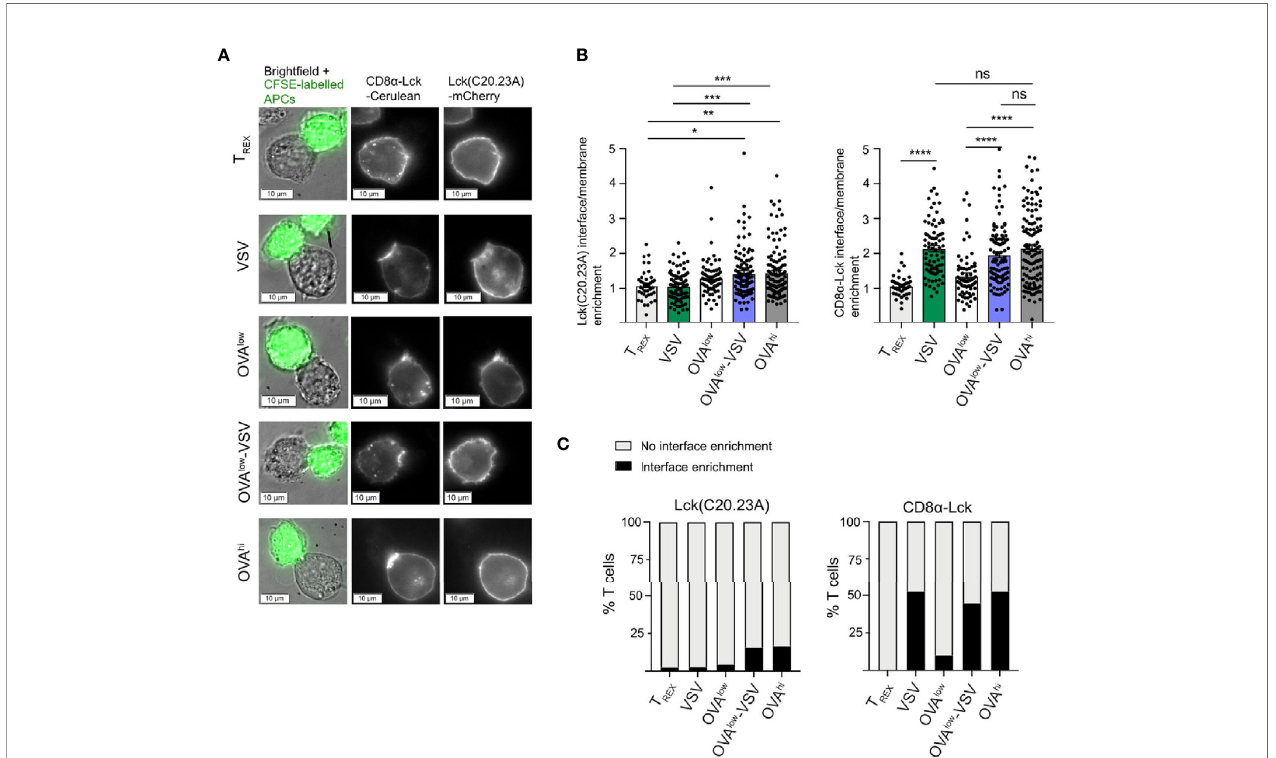
FIGURE 6 | Non-stimulatory pMHC-I recruit CD8-bound Lck to the T cell: APC interface even in absence of antigenic pMHC-I. Endogenous Lck – / – OT-I hybridomas co-expressing Lck(C20.23A)-mCherry (free Lck) and CD8 a -Lck-Cerulean (bound Lck) were co-cultured with the CFSE-labelled CHO APCs labelled for 30 min, followed by fi xation and fl uorescence microscopy analysis. (A) Representative images of T cell: CHO APC conjugates. (B) Recruitment of Lck(C20.23A)-mCherry (left) and CD8 a -Lck-Cerulean (right) to the T cell: APC interface. The interface recruitment was calculated as (mean pixel intensity at the interface – background)/(mean pixel intensity at membrane outside the interface – background). (C) Percentage of T cells with interface enrichment of free (left) and bound (right) Lck. The interface Lck enrichment was de fi ned by the interface enrichment values of 2 and above. Data from 3 independent experiments, with 41 conjugates for T REX , 79 conjugates for VSV, 69 conjugates for OVA low , 103 conjugates for OVA low +VSV and 120 conjugates for OVA hi . Statistical signi fi cance was calculated using one-way ANOVA, with Tukey ’ s multiple comparisons test. *P < 0.05, **P < 0.01, ***P < 0.001, ****P < 0.0001, ns, P ≥